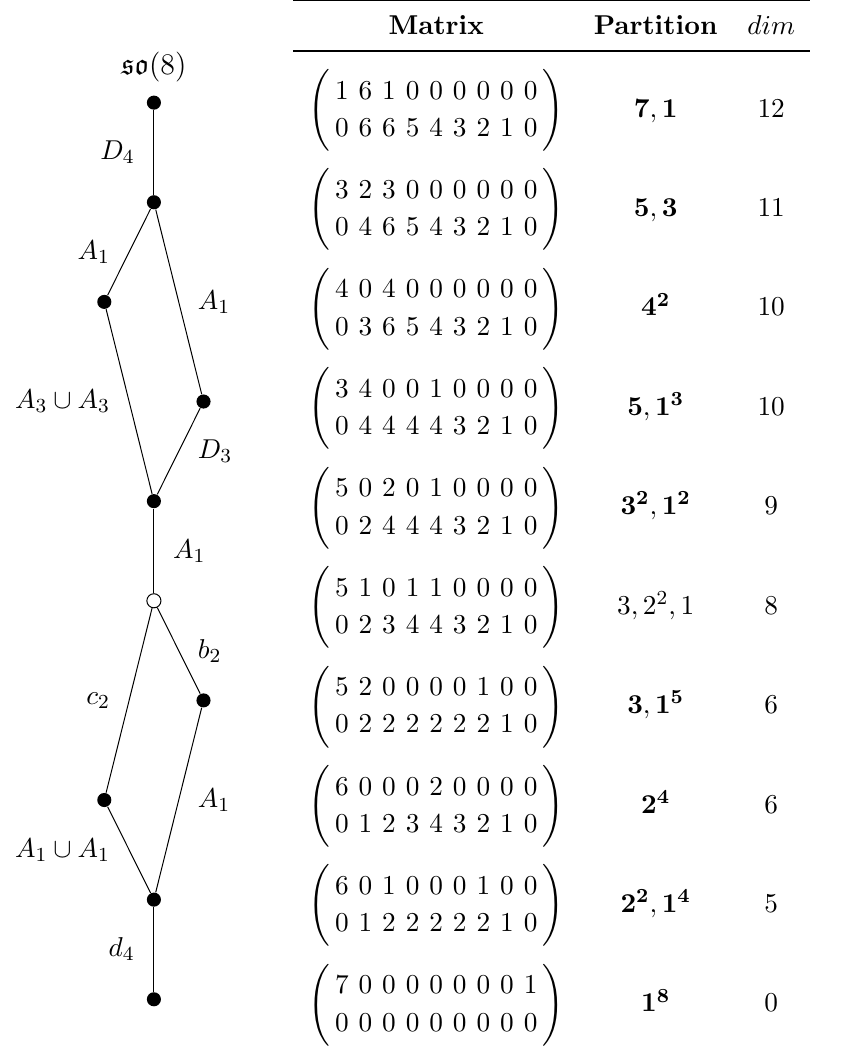
Table 15. Results obtained applying the matrix formalism to so (8).